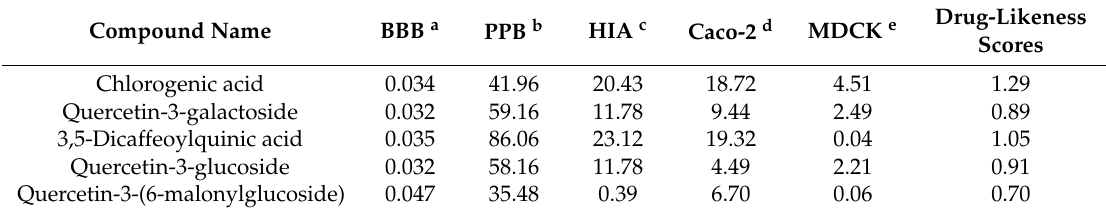
Table 2. ADME (absorption, distribution, metabolism, excretion) properties and drug-likeness scores of the main components present in the C. olitorius extract.